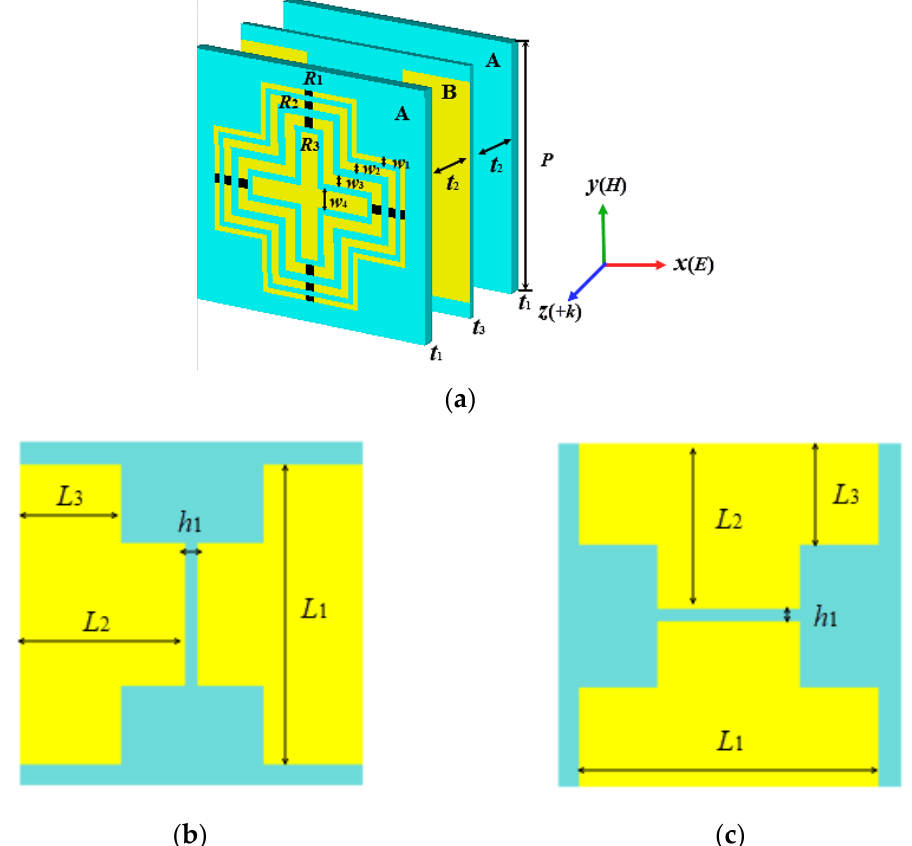
Figure 1. The designed absorber. ( a ) Lateral view of the absorber; ( b ) front view and ( c ) back view of layer B.